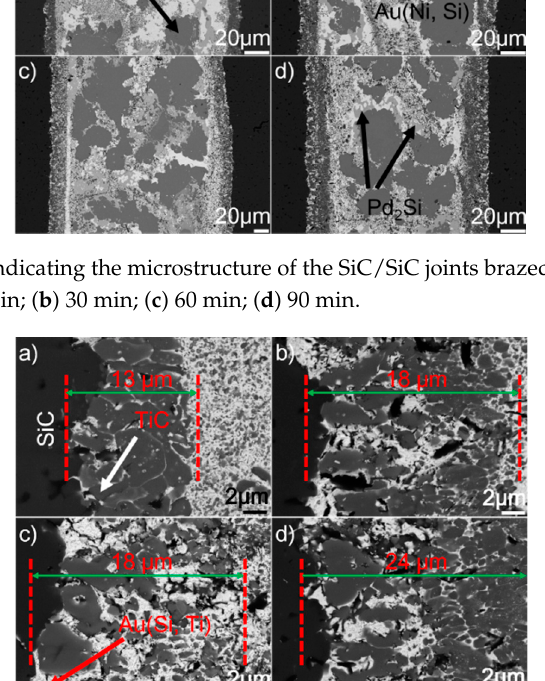
Figure 10. BSE images indicating the braze seams obtained at 1523 K for different soaking times: ( a ) 10 min; ( b ) 30 min; ( c ) 60 min; ( d ) 90 min. 3.4. Fracture Morphologies of the Joints